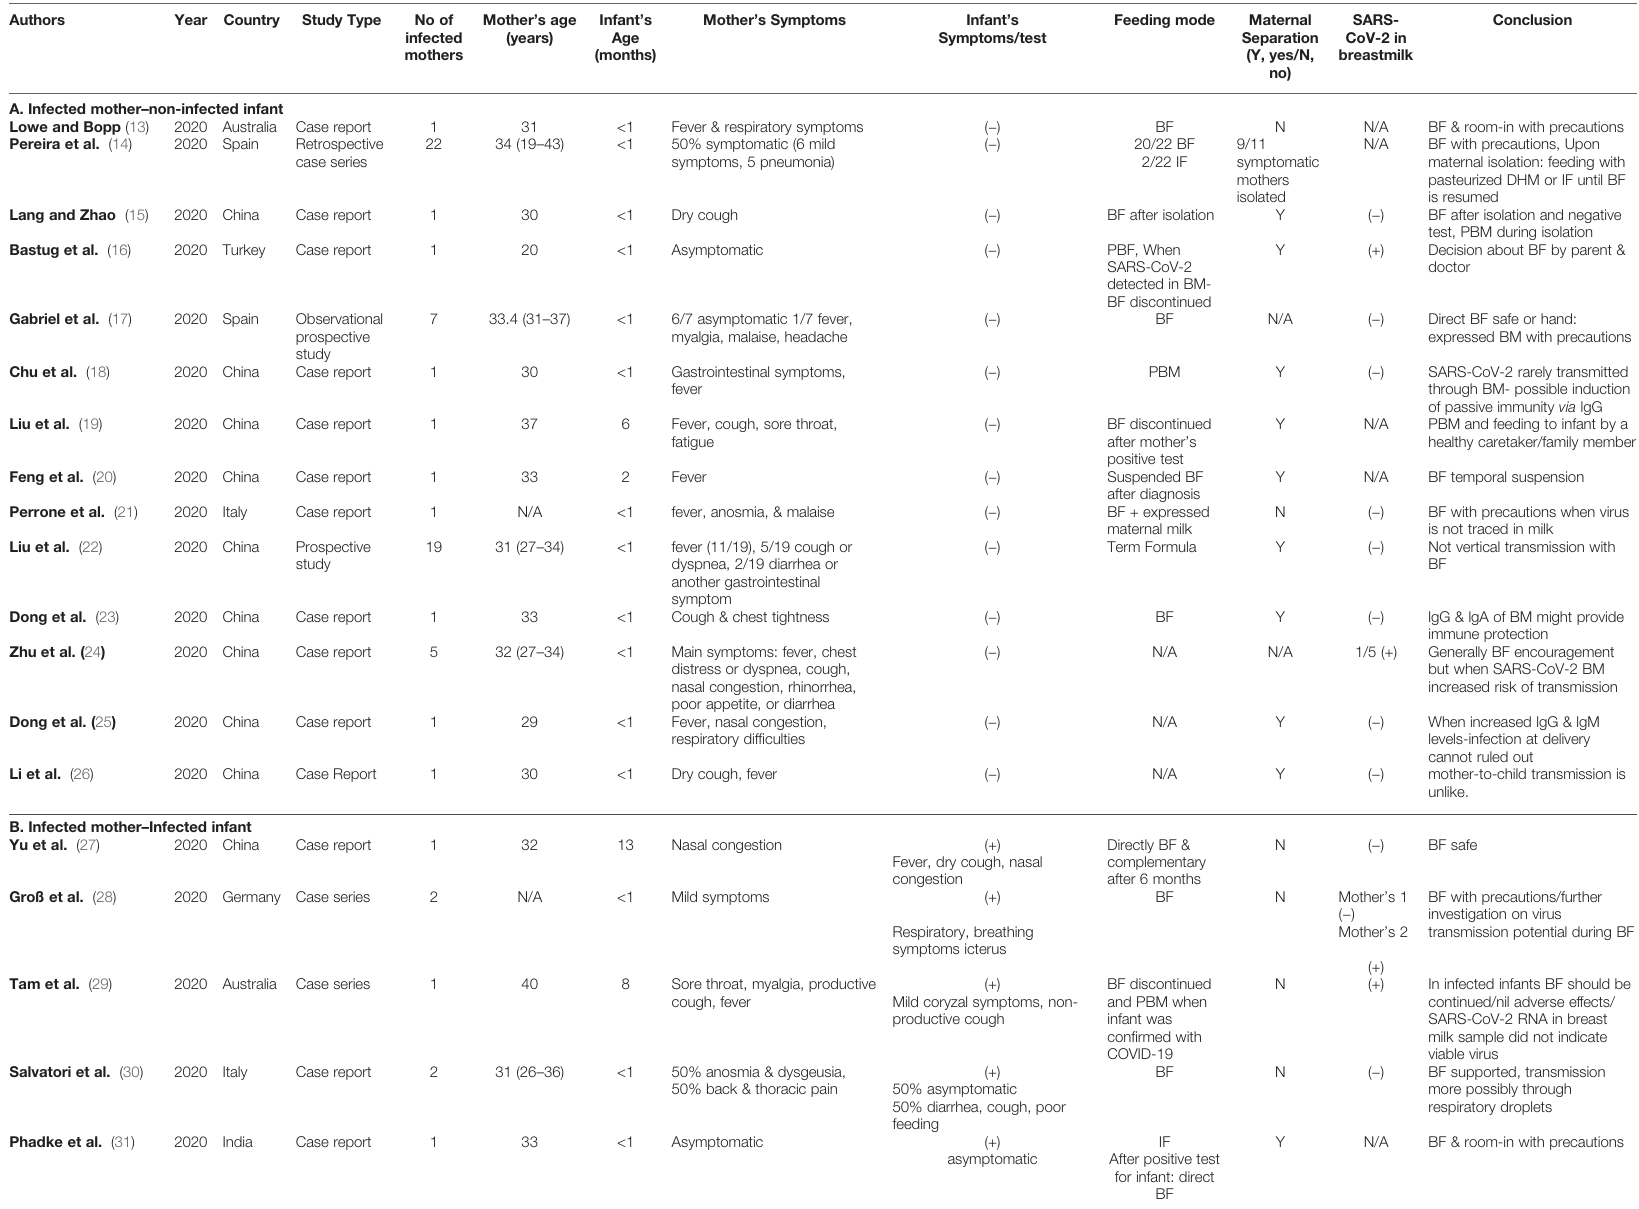
TABLE 1 | Studies included in the review of breastfeeding (BF) and SARS-CoV-2 infection